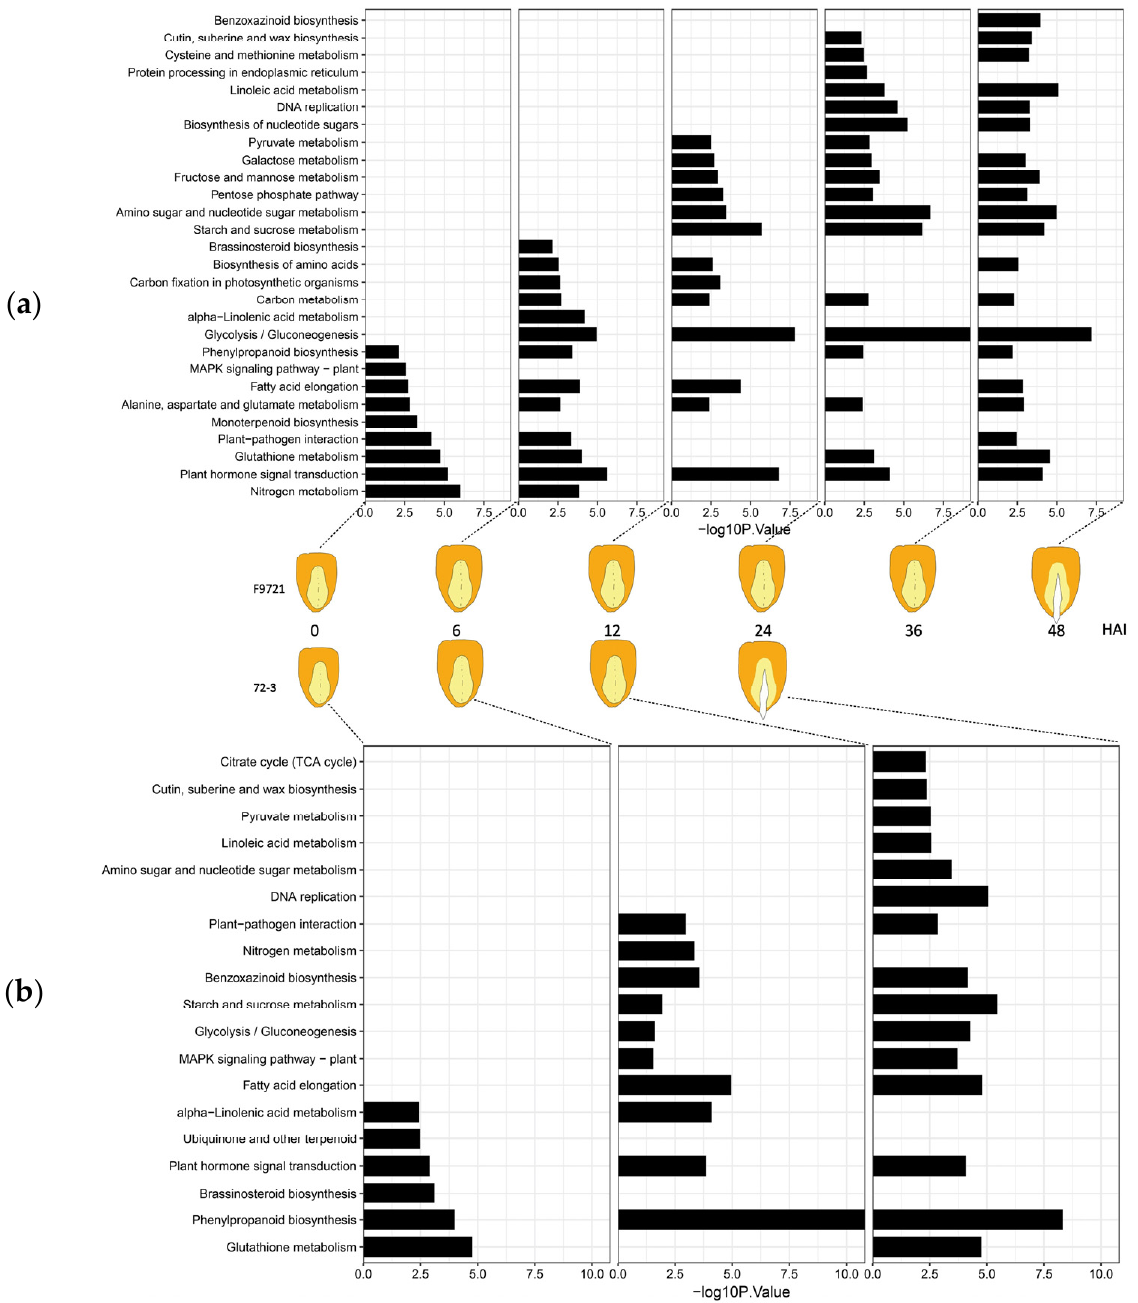
Figure 2. Time series (0, 6, 12, 24 HAI of line 72-3 and 0, 6, 12, 24, 36, 48 HAI of line F9721) transcriptome dynamics indicated by KEGG of DEGs between imbibing and dry seeds. ( a ) Time series (0, 6, 12, 24, 36, 48 HAI) transcriptome dynamics of F9721 between imbibing and dry seeds. ( b ) Time series (0, 6, 12, 24 HAI) transcriptome dynamics of 72-3 between imbibing and dry seeds.